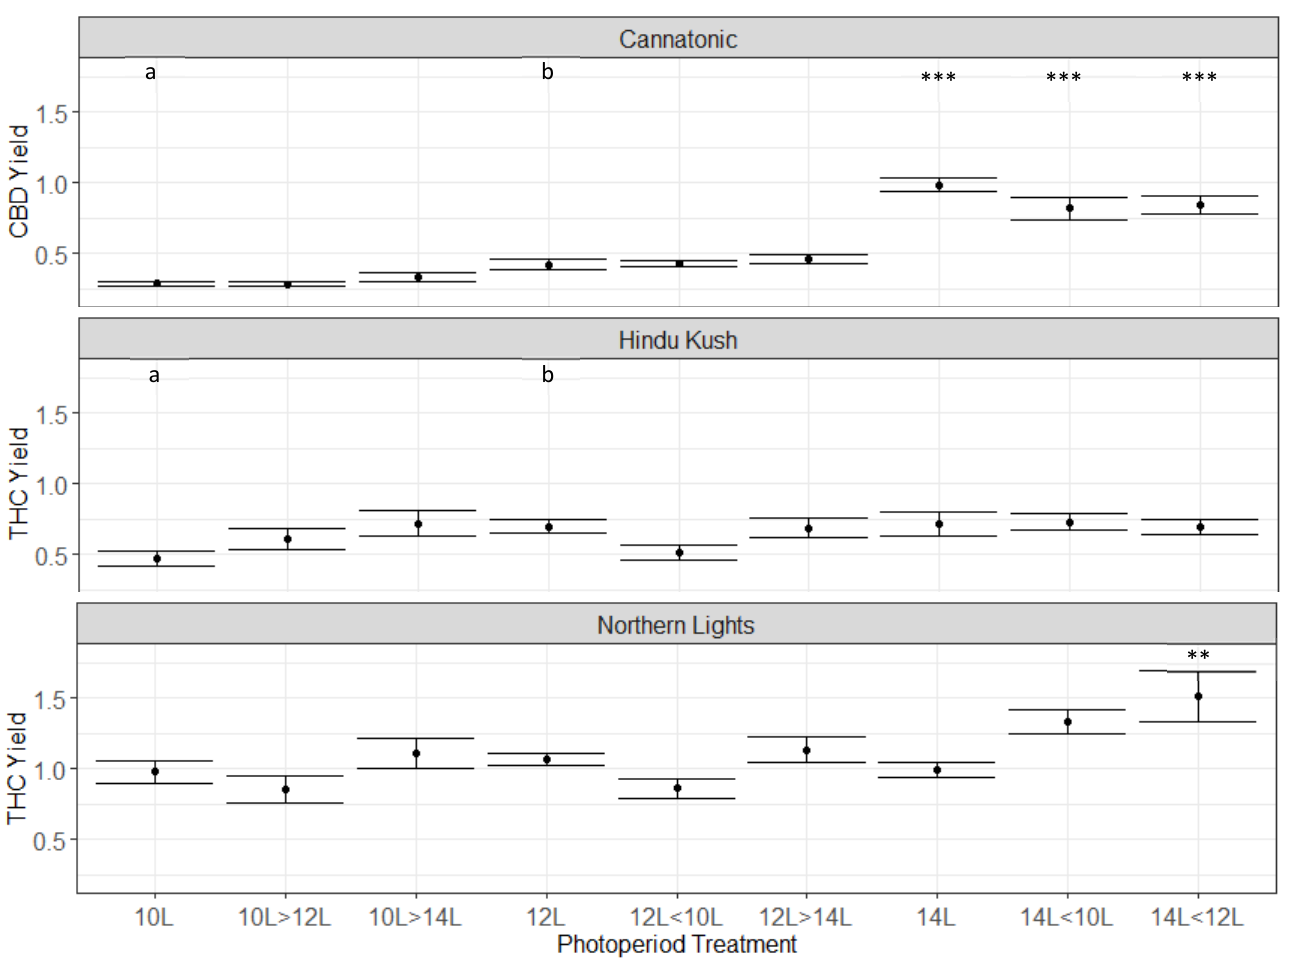
Figure 6. Total yield (g plant − 1 ) of the target cannabinoid in the three genotypes. Asterisks above the error bars indicate that the treatment was significantly different to the control 12L treatment, Dunnet’s test, *** p ≤ 0.001, ** p ≤ 0.01, N = 4 − 5 +/ − SE. Di ff erent le tt ers above the 10L and 12L treatments show significant differences between those two treatments (two-way t-test assuming unequal variance) p ≤ 0.05.